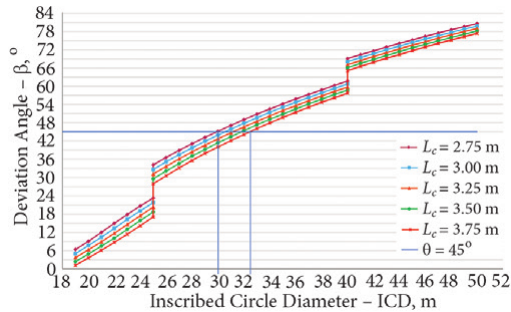
Figure 3. Deviation angle for roundabouts with θ equal to 180° and R app /R entry /R exit /R dep equal to 75/15/18/72, m